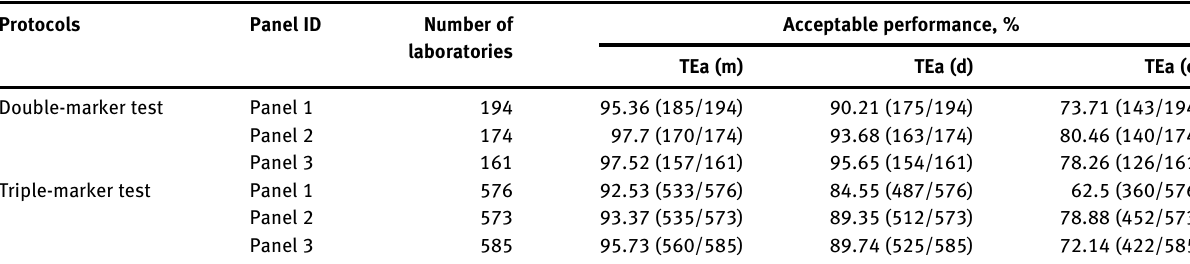
Table  : The acceptable performances of different screening protocols under different performance speci fi cations.